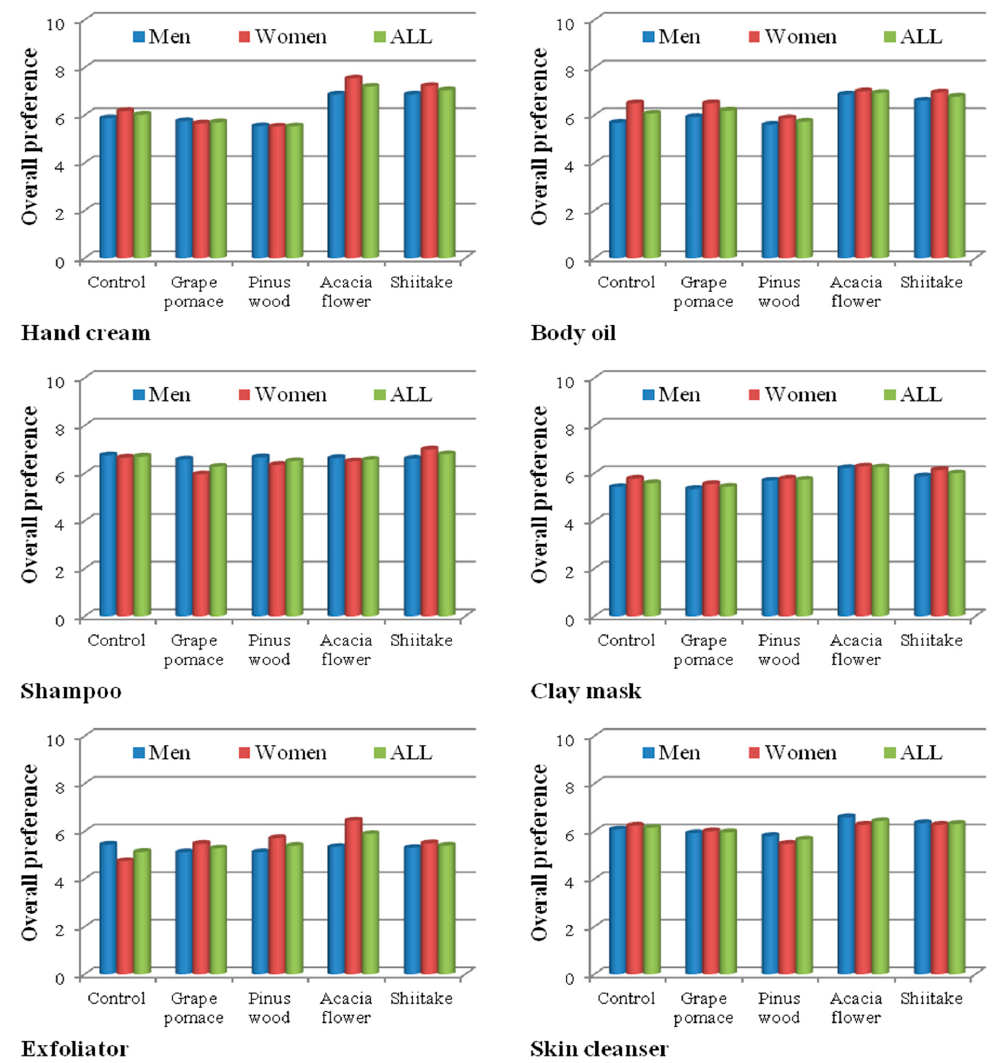
Figure 2. Overall appreciation for tested personal-care products according to the volunteers’ gender.